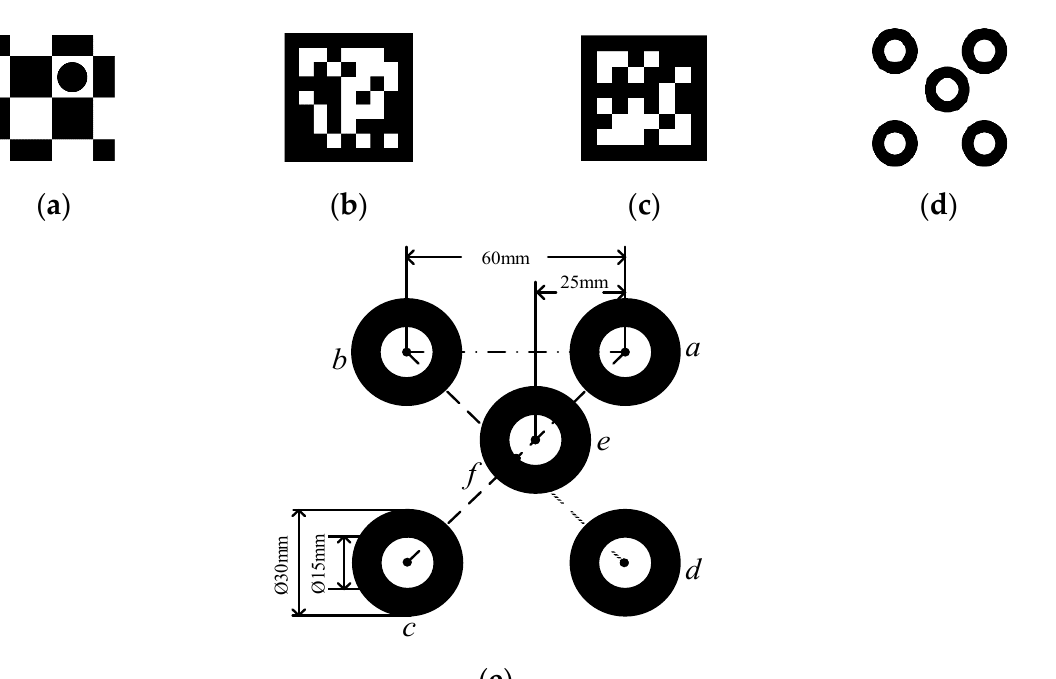
Figure 1. Four markers: ( a ) Checkerboard; ( b ) ArUco; ( c ) AprilTag; ( d ) Circular ring; ( e ) The proposed Circular-ring marker size design.